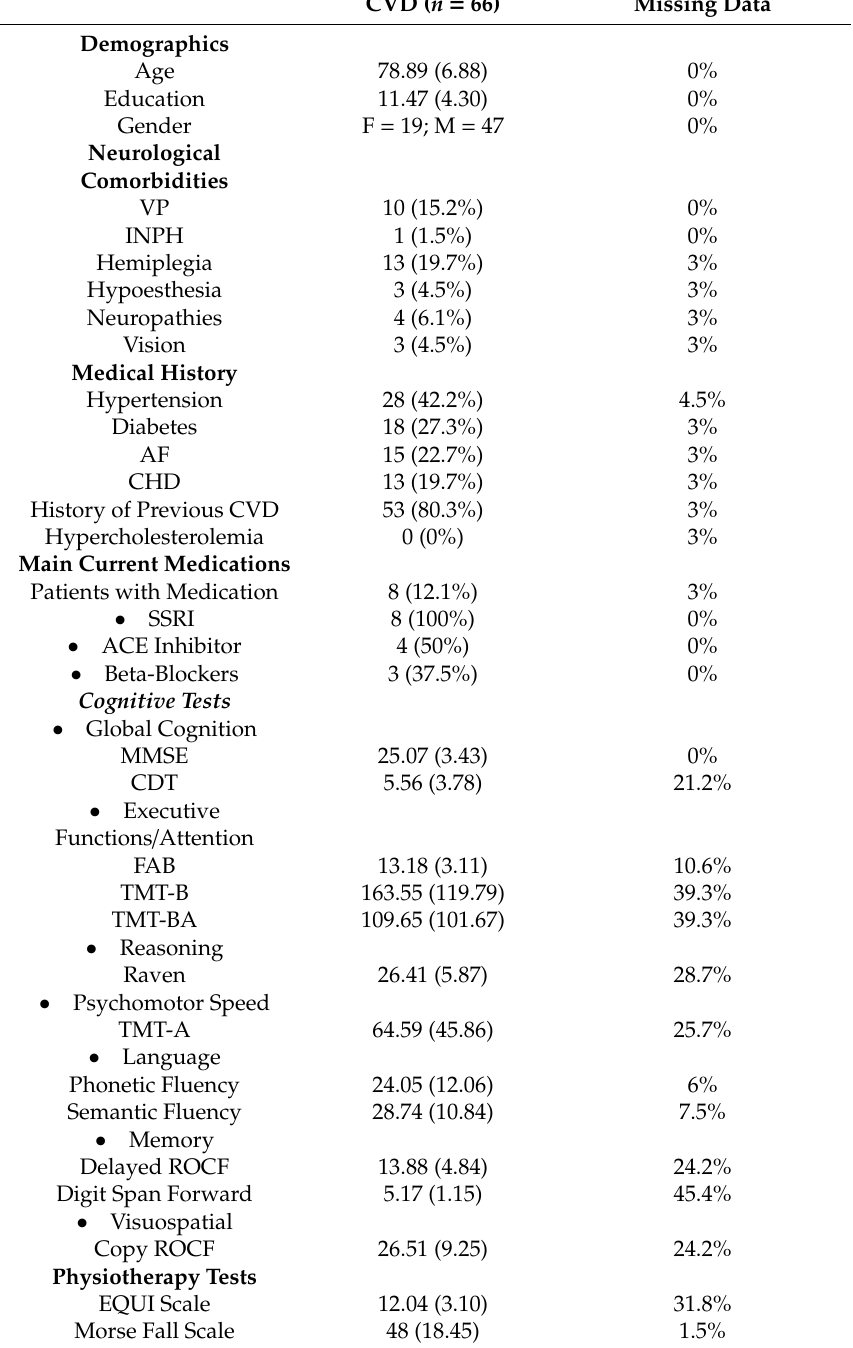
Table 1. Demographics and clinical characteristics of the